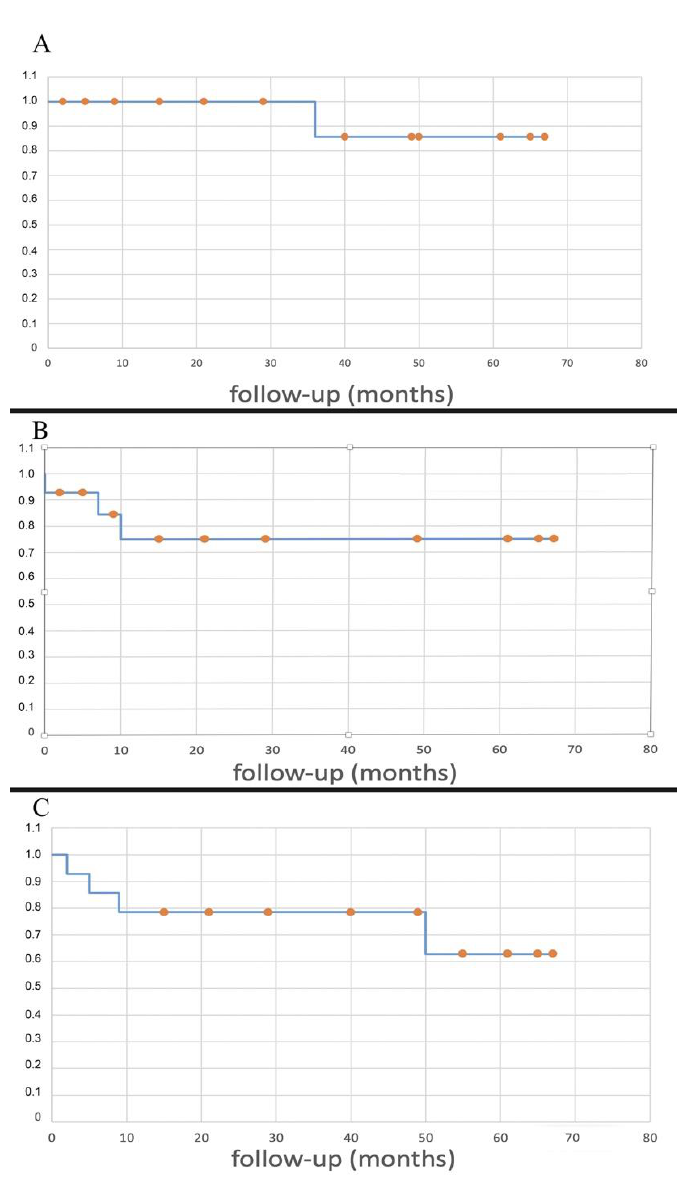
Figure 6. Kaplan–Meier curves showing LRFS ( A ), DMFS ( B ), OS ( C